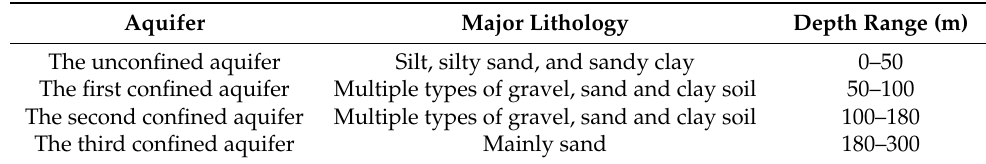
Table 2. Division of aquifers in the Beijing Plain